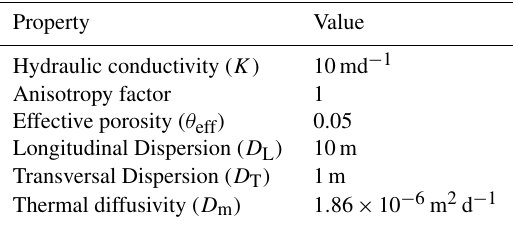
Table 1. Aquifer parameters. Values are chosen according to those typical for homogenous sandy aquifers ( K : Domenico and Schwartz, 1998; θ : Woessner and Poeter, 2020; D L : Schulze- Makuch, 2005). D T is chosen ten times lower than D L , which is common practice (Zech et al., 2019) and D m is chosen according to the reference values from the German Engineer Association guide- lines for thermal use of the underground (VDI,